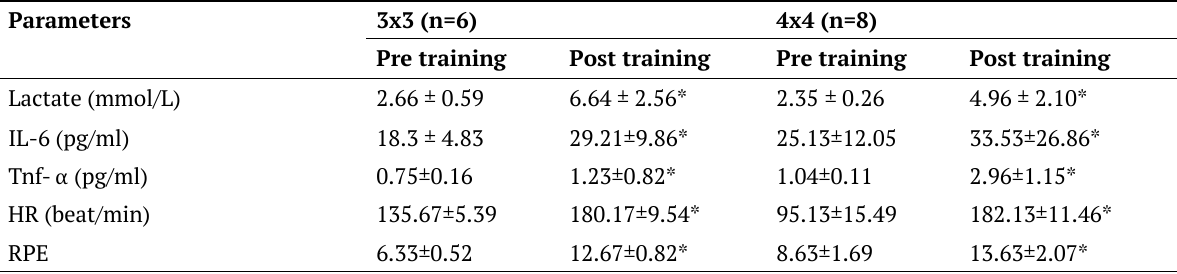
, HR and RPE levels of the participating α